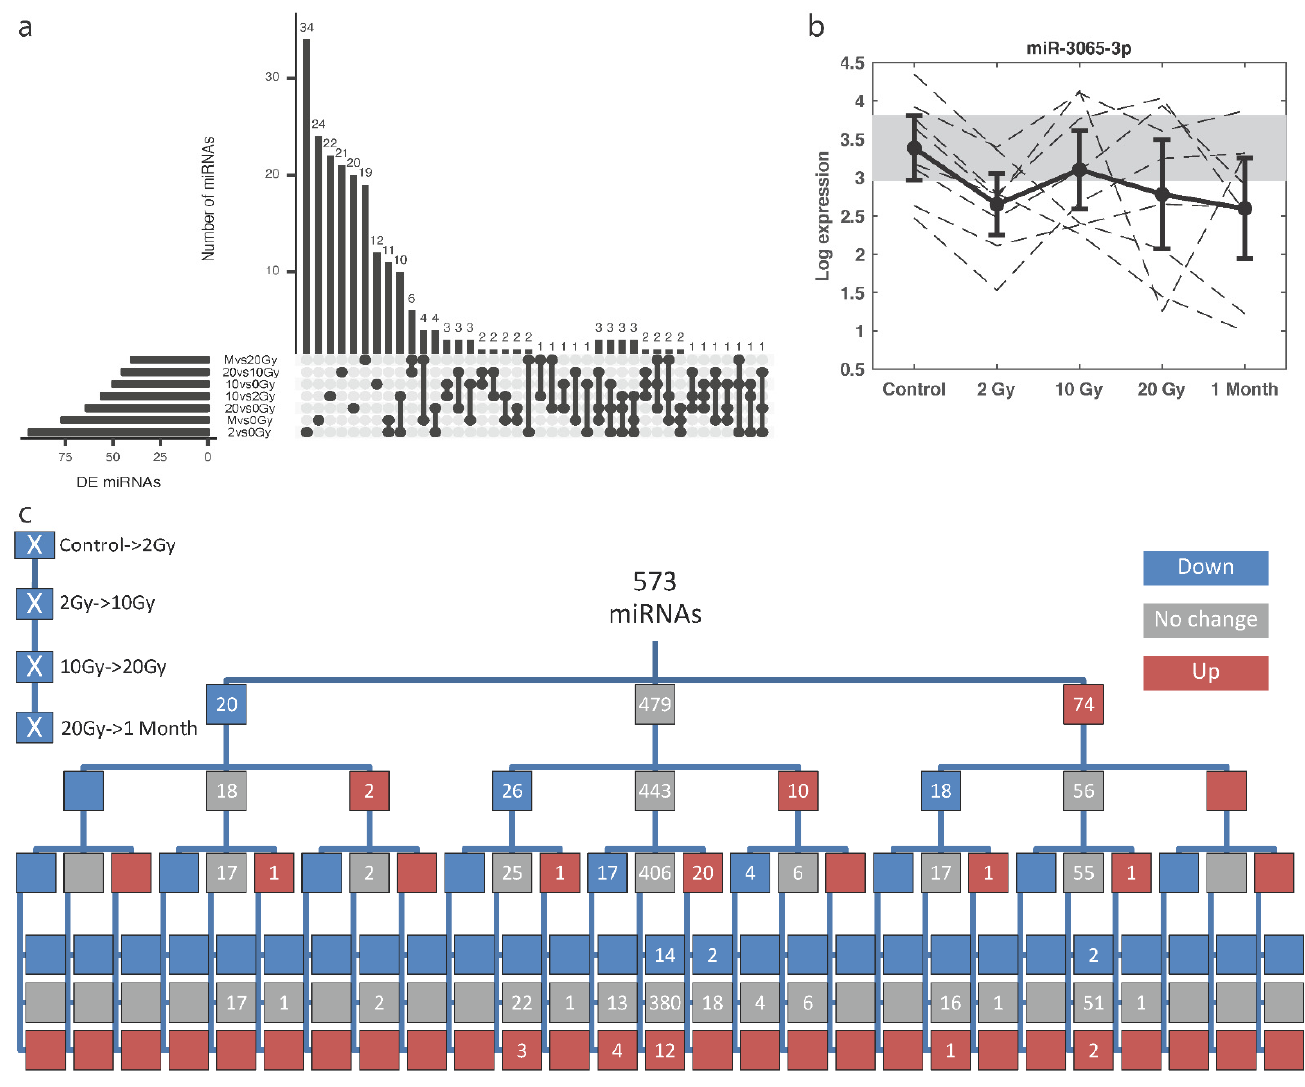
Figure 2. Discovery of differentially expressed (DE) miRNAs analysed in the training cohort. ( a ) UpSet plot that shows intersection of DE miRNAs among comparisons between different total doses. M represents one month after end of therapy (46/50 Gy in total); ( b ) Expression of a significantly different miRNA in 2 Gy versus control, after multiple testing correction; ( c ) Trend patterns diagram of miRNAs. Box colours represent downregulation (blue), no change (grey), or upregulation (red) versus the adjacent, lower total dose (or versus control for 2 Gy). The lowest branch level is drawn vertically to save space. The numerical value corresponds to the number of miRNAs in that branch.